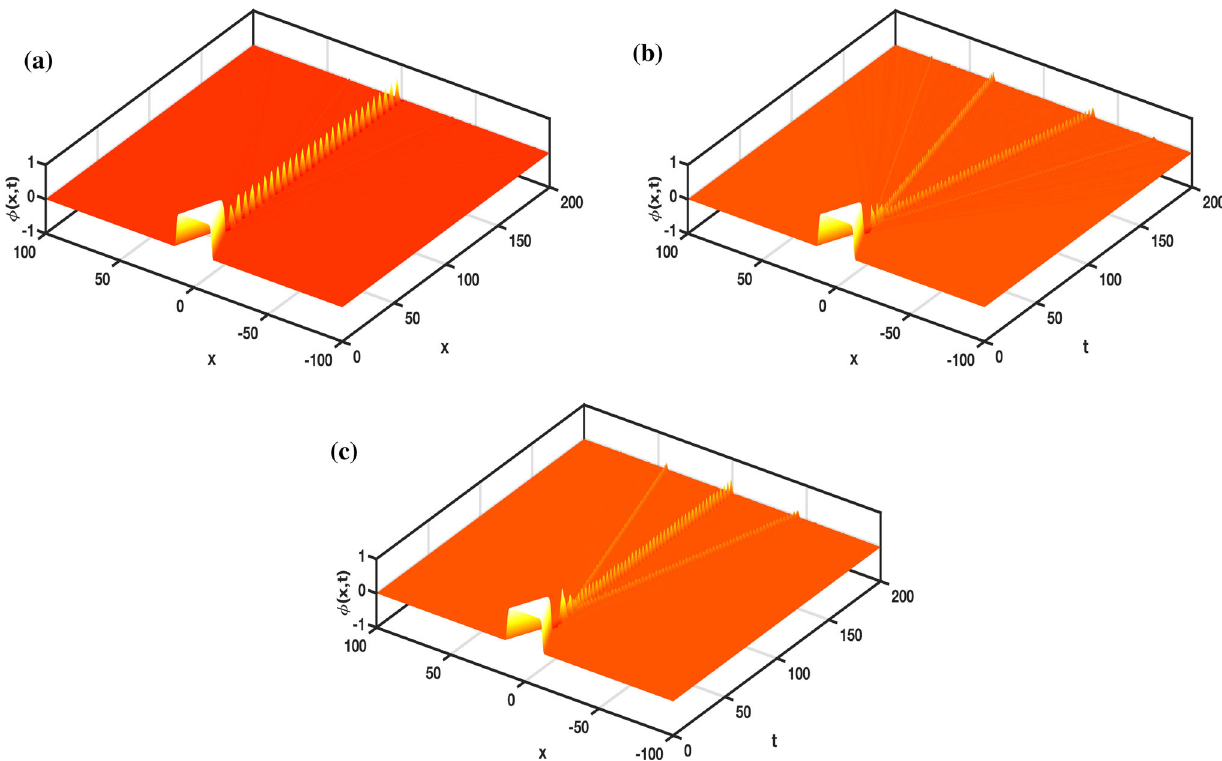
Fig. 8 Kink-antikink collisions and formation of oscillating pulses for n = 7 with a v = 0 . 3896 – bion, b v = 0 . 445 – two pulses and c v = 0 . 4562 – three